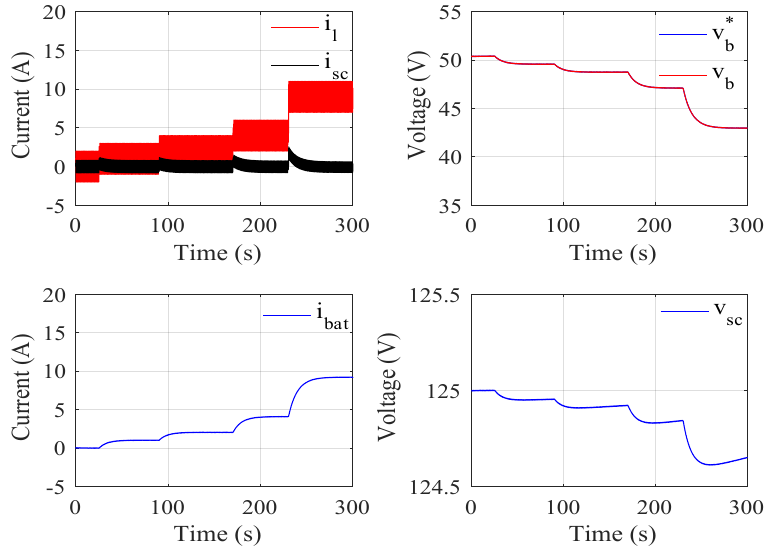
Figure 9. Simulation results: 100% SOC.